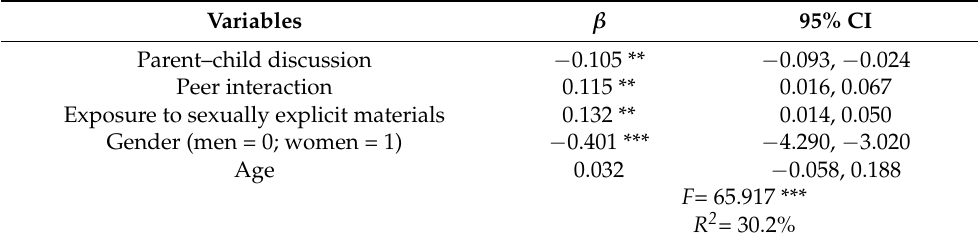
Table 3. Associations of parent–child discussion, peer interaction, exposure to sexually explicit materials, gender, and age with casual sex intention: multiple regression analysis ( n = 767).